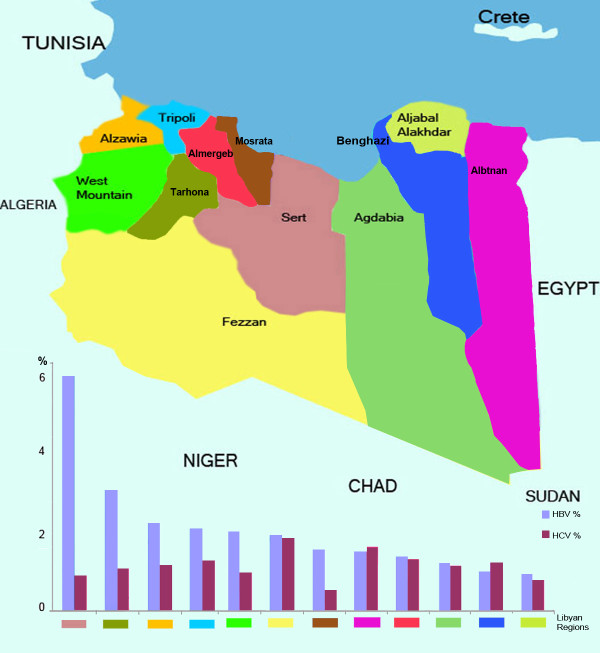
Map of Libya showing the prevalence of hepatitis B and C infections by region.